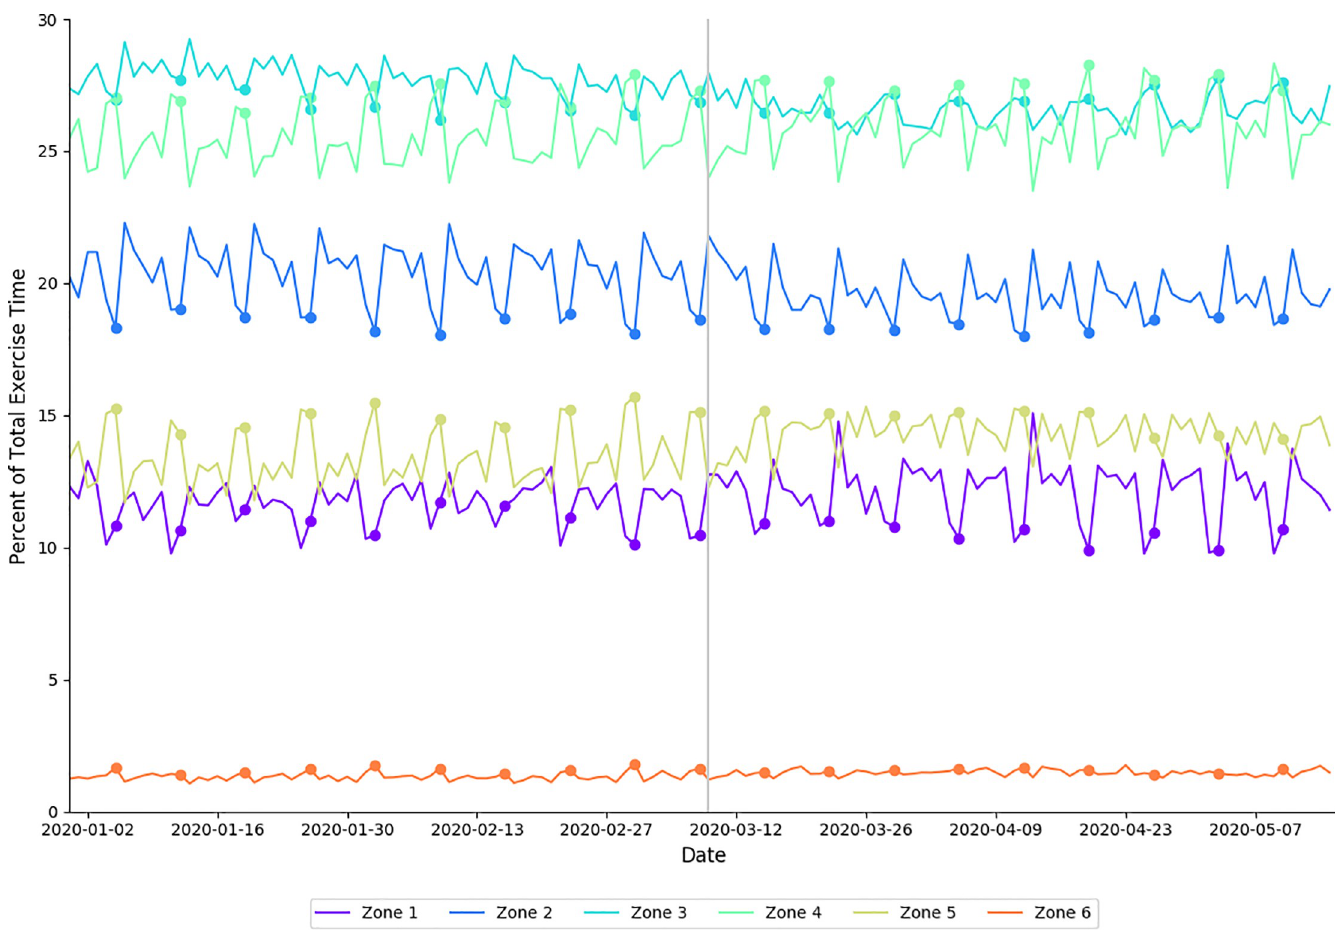
Fig 4. Distribution of proportion of total exercise time spent in each heart rate zone in 2020, arranged by date. Each heart rate zone is shown in a different color, indicated by the legend. Filled circles indicate Sundays; the vertical gray line delineates between baseline and physical distancing.